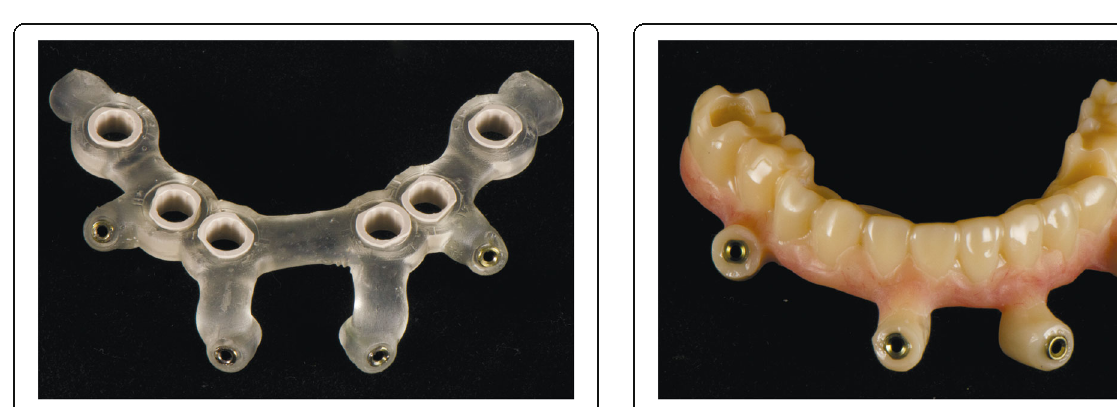
Fig. 8 Computer-aided manufacturing of interim prosthesis with